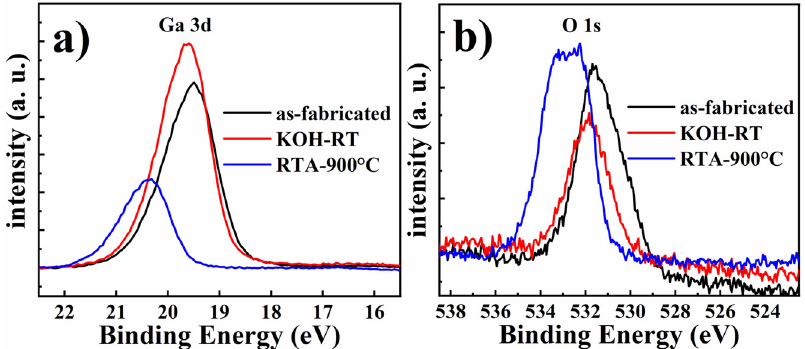
Figure 9. High resolution Ga 3d ( a ) and O 1s ( b ) XPS core level spectra of III-polar nanopillar MQWs without treatment and after KOH or RTA treatments.